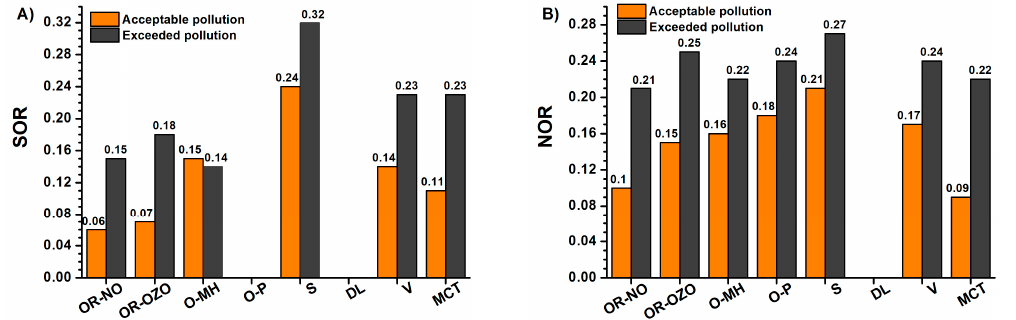
Figure 6. ( A ) Average values of sulphur oxidation ratio (SOR) and ( B ) nitrogen oxidation ratio (NOR) for acceptable pollution and exceeded pollution .